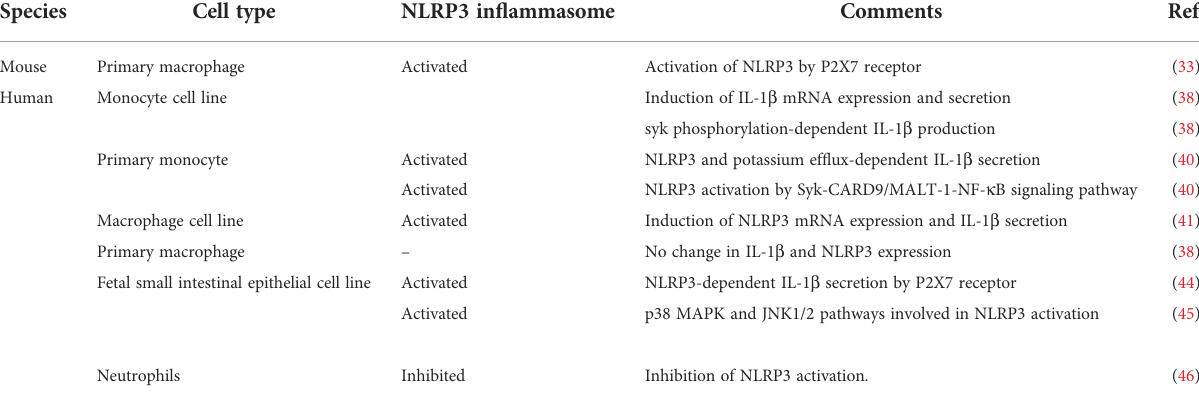
TABLE 1 Mechanisms of NLRP3 in fl ammasome regulation in various T. gondii -infected cell types.